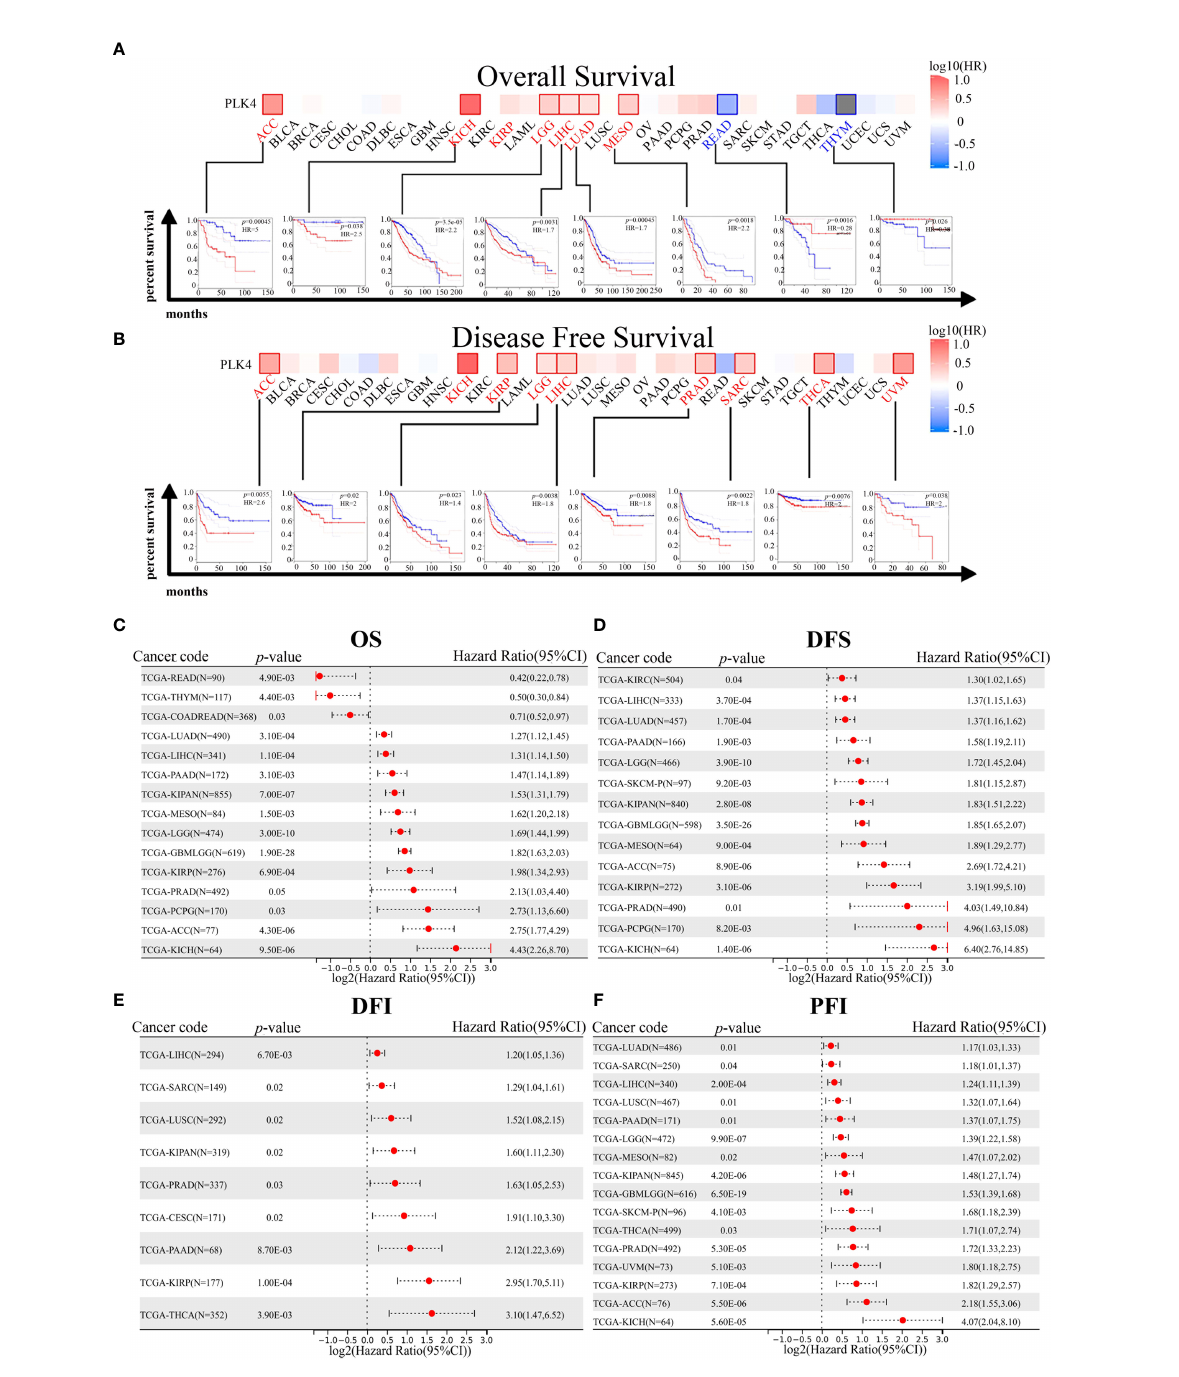
FIGURE 4 Correlation between PLK4 expression and survival prognosis for various cancers in TCGA. We analyzed overall survival (OS) (A) and disease-free survival (DFS) (B) using the log-rank test in different tumor types from TCGA. A survival map with positive results is shown. The correlation between PLK4 expression and overall survival (OS) (C) , disease free survival (DFS) (D) , disease free interval (DFI) (E) , and progression free interval (PFI) (F) in different cancer types using Cox regression survival analysis for TCGA